Question: How would you classify this visualization?
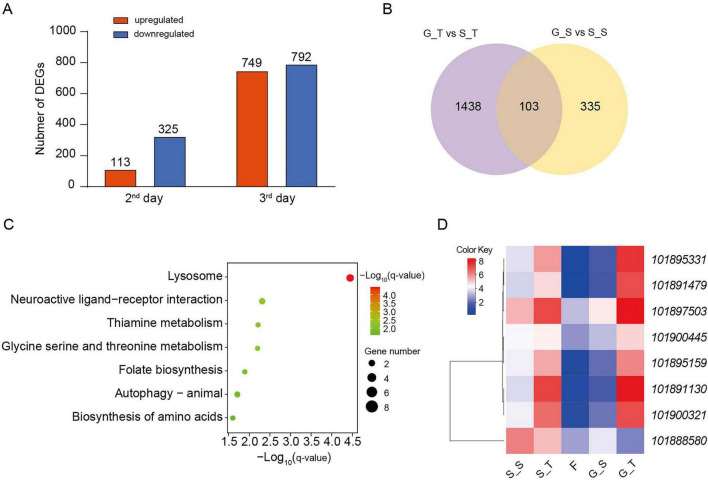
Answer: heatmap